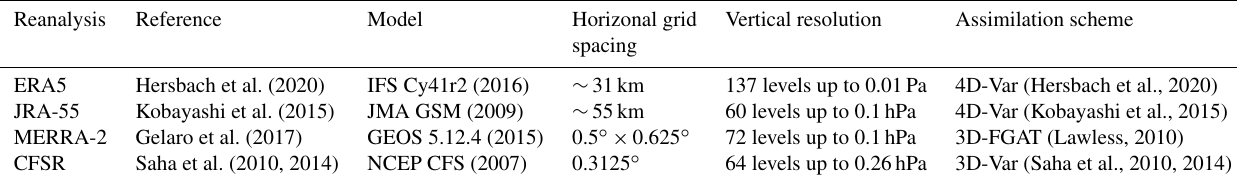
Table 1. Key characteristics of ERA5, JRA-55, MERRA-2, and CFSR reanalysis systems. The abbreviations used are IFS (Integrated Forecast System), JMA GSM (Japanese Meteorological Agency Global Spectral Model), GEOS (Goddard Earth Observing System Model), NCEP CFS (National Center for Atmospheric Research Climate Forecast System), 3D-FGAT (three-dimensional first-guess-at-appropriate-time assimilation scheme), 4D-Var (four-dimensional variational data assimilation), and 3D-Var (three-dimensional variational data assimilation). In the column labelled “Model” the year indicates the year for the version of the forecast model that was used for the